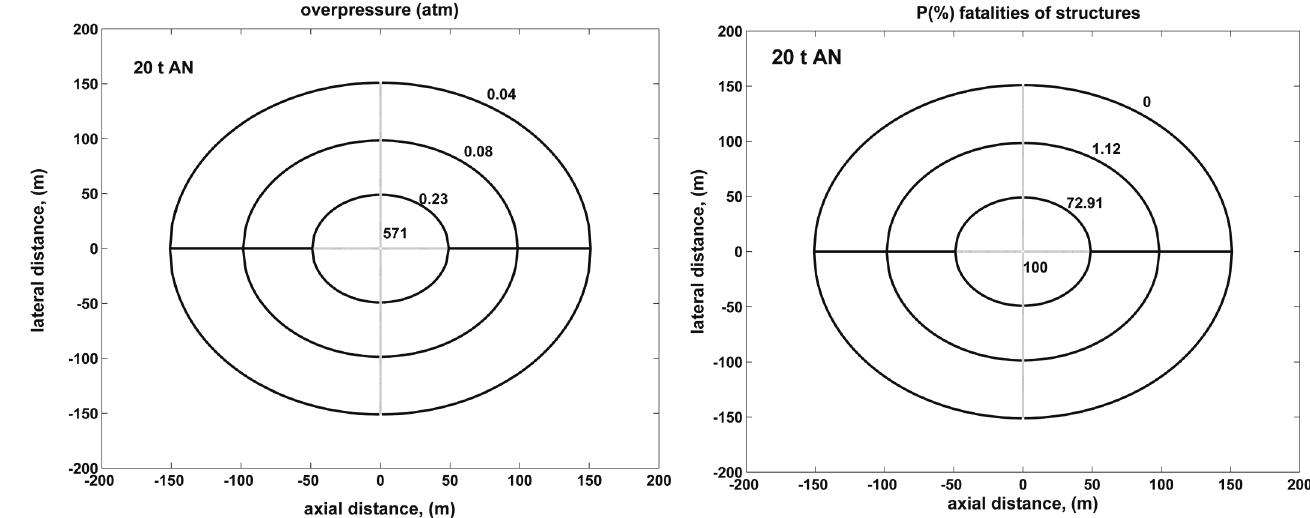
Fig. 4 – P% fatalities of structures (buildings, industrial plants) at various distances (50 m, 100 m, and 150 m) from the explosion spot (case of 20 t AN